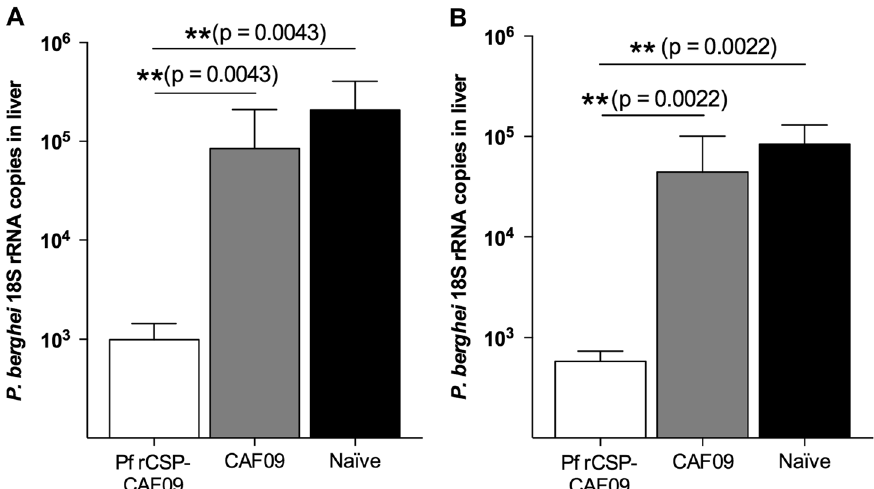
Fig. 3 P.b.-P.f. CSP-FL CD8CT parasite liver burdens in mice immunized with Pf rCSP-CAF09. Mice immunized a two times or b three times with Pf rCSP-CAF09 signi fi cantly inhibited sporozoite infection compared to adjuvant-only (CAF09) or naïve controls. Geometric mean with 95% con fi dence interval; n = 6 per group. Abbreviations: Pf rCSP-CAF09 , P. falciparum recombinant circumsporozoite protein in adjuvant CAF09; P.b.- P.f. CSP-FL CD8CT, P. berghei – P. falciparum CSP full-length CD8 epitope C-terminus transgenic parasite; rRNA, ribosomal RNA; RT-qPCR reverse- transcription quantitative real-time polymerase chain